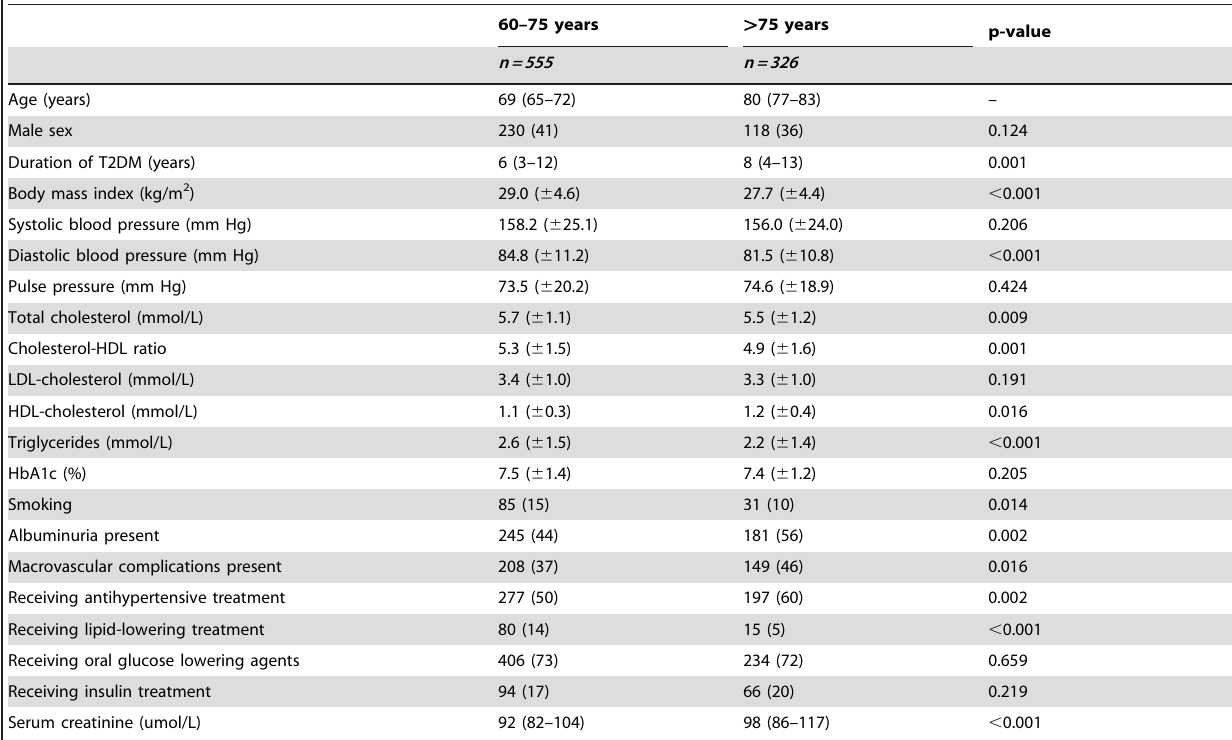
Table 1. Baseline characteristics.